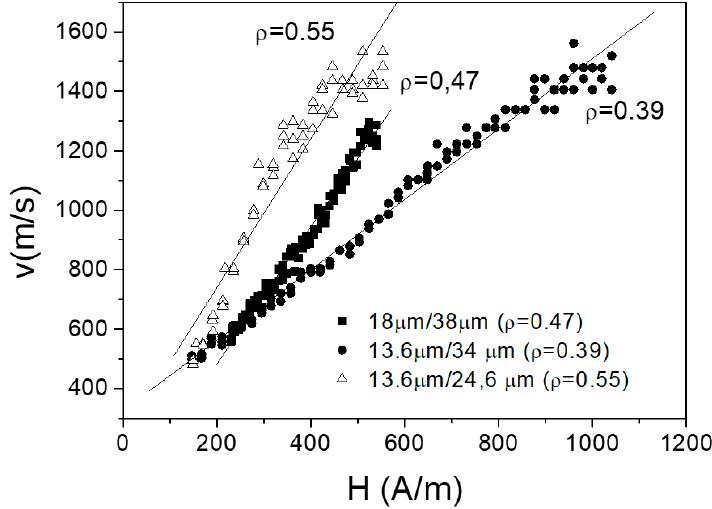
Figure 10. Magnetic field dependences of DW velocity for sample № 2 microwires with various ρ ratio. Reprinted with permission from [6].